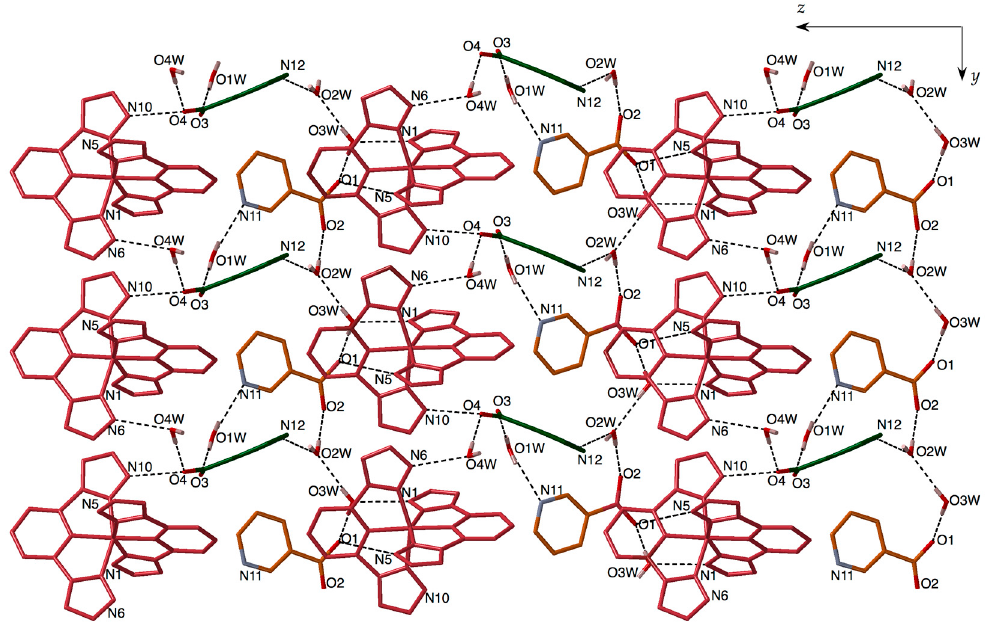
Figure 2. A view of the crystal structure of 1 · 4H 2 O along the a axis, showing the alternation of [Fe(bpp) 2 ] 2+ cationic layers and nicotinate anionic layers. The iron complexes are illustrated in red whereas the two independent nicotinate anions are depicted in orange and green. The dashed lines refer to hydrogen bonds. Only the H atoms of water molecules are shown.